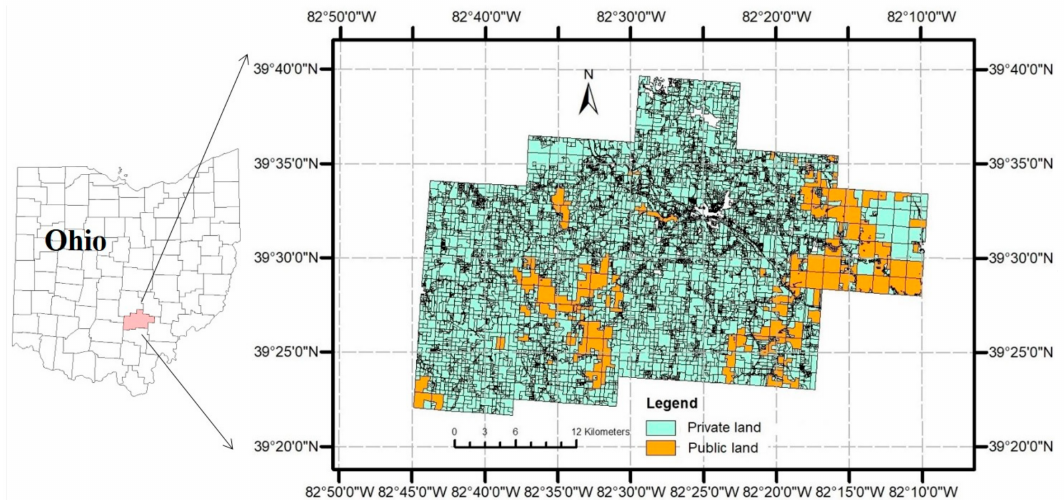
Figure1. Thestudyarea(HockingCountyinSoutheasternOhio, USA)andtheparcelsoflandownership.